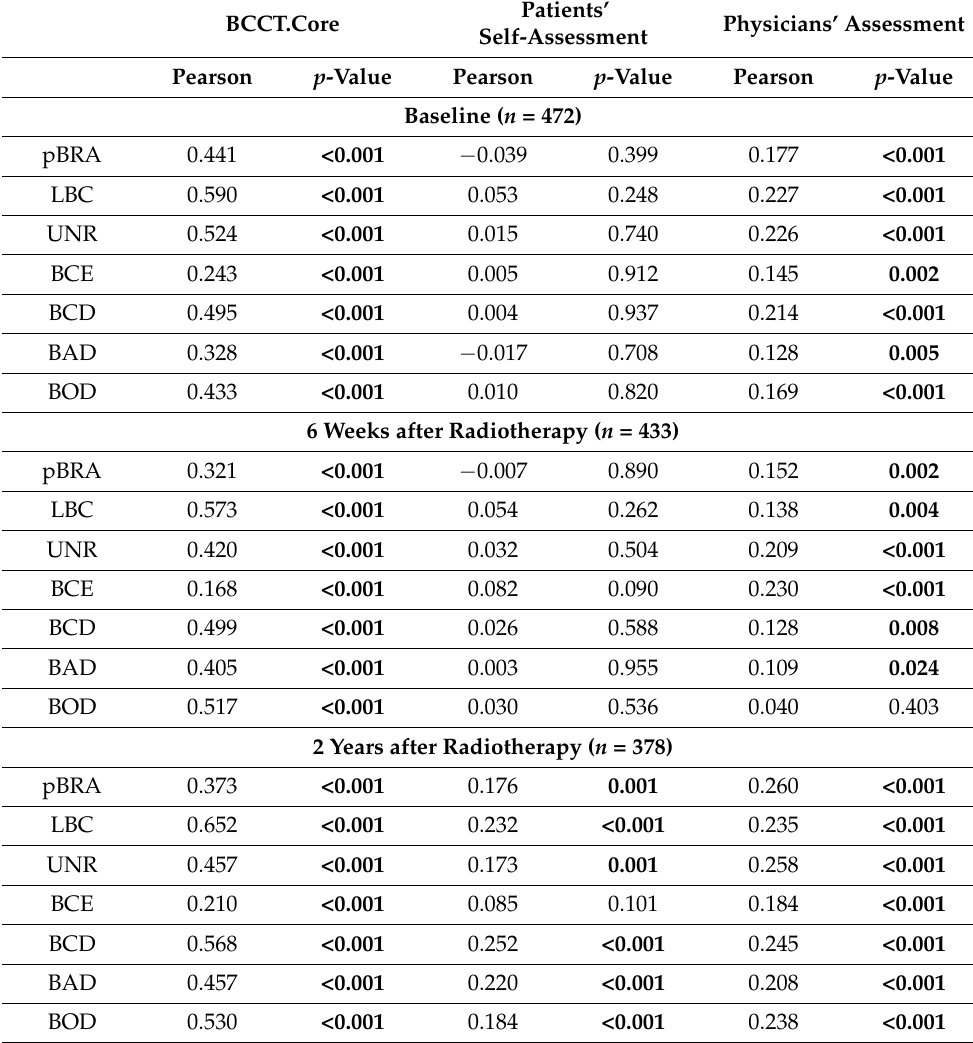
A Pearson correlation score was used to determine correlation between breast asymmetry indices and overall cosmetic outcomes of BCCT.core, as well as between breast asymmetry indices and patients’ or